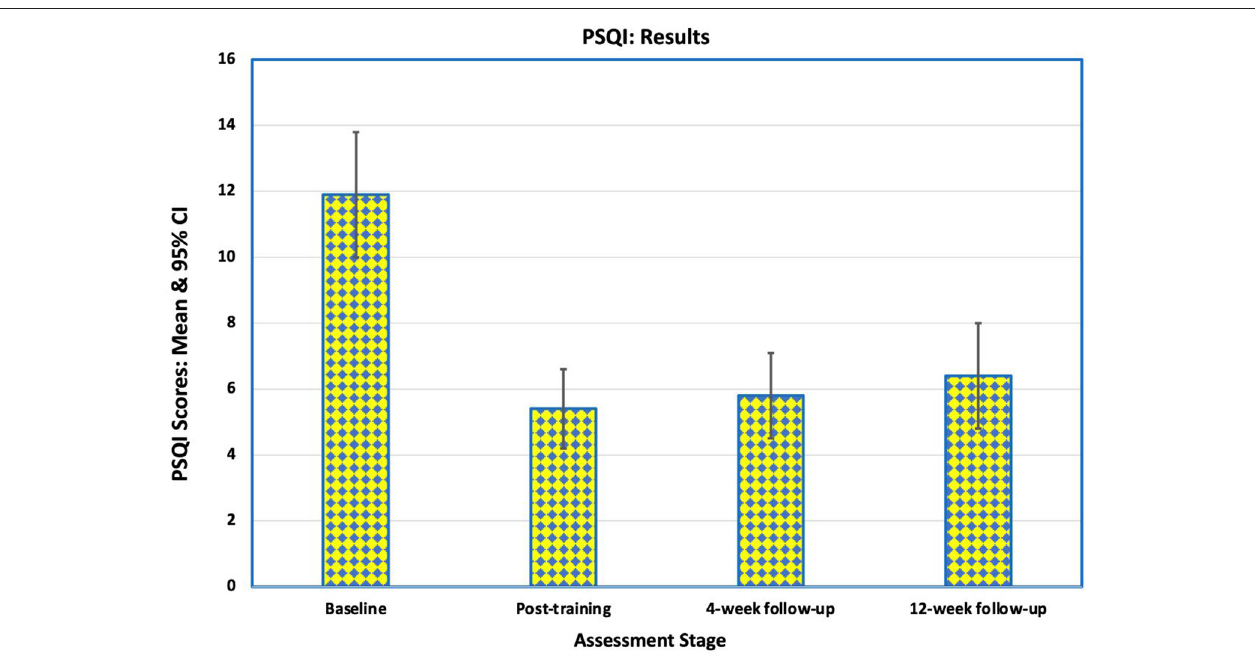
FIGURE 6 | Mean scores on Pittsburgh Sleep Quality Index (PSQI) for the 16 participants at baseline, immediately after training, at 4-week follow-up and at 12-week follow-up. These scores indicate an improvement in the quality of sleep during the study and over the follow-up period. Of the 8 participants who had poor sleep before training and good sleep at the end of training, 7 continued to report good sleep 12 weeks after the